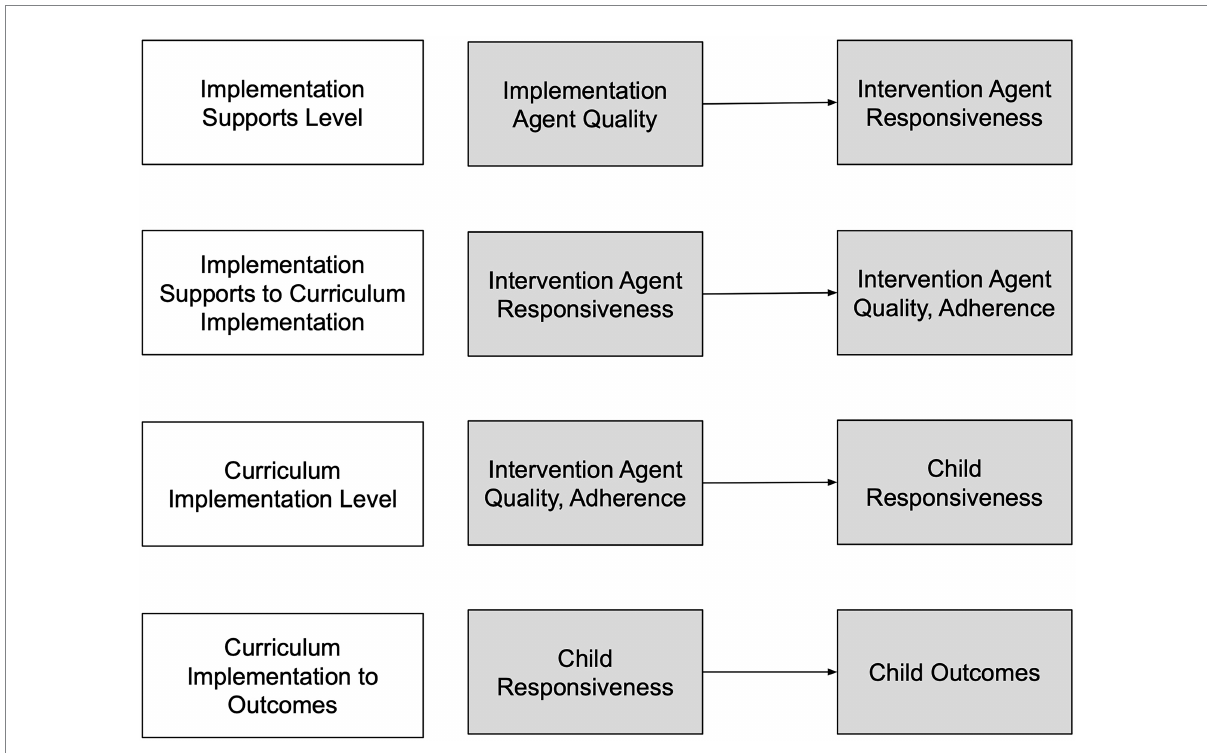
FIGURE 3 Example hypothesized relations between and within intervention implementation levels and outcomes. Outcomes refers to program impacts for children. In our study, implementation agent refers to our implementation director and intervention agent refers to preschool teachers implementing the MindUP ™ curriculum in their classroom with